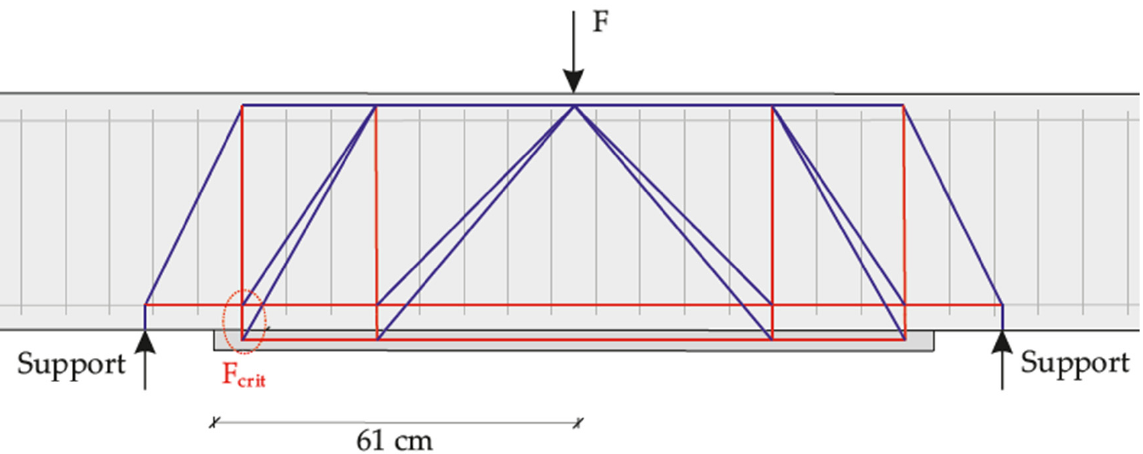
Figure 12. Strut-and-tie-model for the calculation of the critical tensile force, that induced concrete cover separation. (Graphic: CARBOCON GMBH).